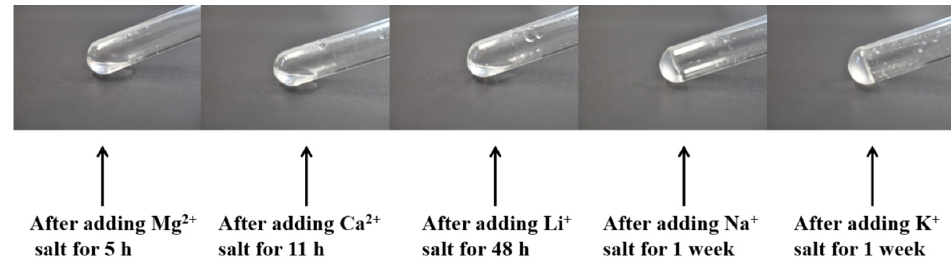
Figure 2. Influence of cations on the B8-BMPTFSI gel. Table 1. CGCs of B8 required to gel the BMPTFSI solution of different NaTFSI concentrations, and the corresponding conductivity of gel ( σ ).